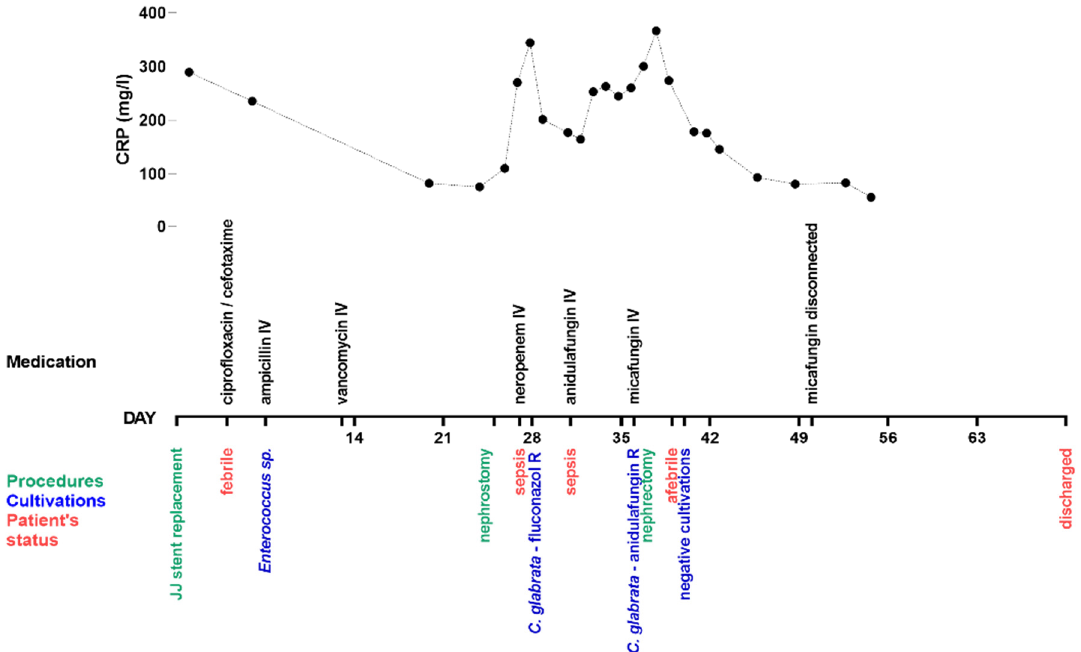
Figure 1. The timeline of case development. The timeline summarizes urinary tract instrumentation and surgical procedures (green), results from blood and urine cultivations (blue), patient’s status (red), medication (black) and a line plot of C-reactive protein (CRP) values (reference range 0–5 mg/L). Table 1. Results from the biochemical analyses performed during the case development.